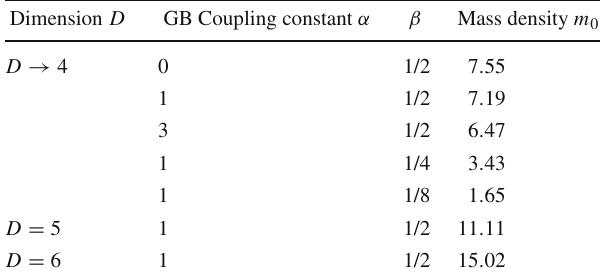
Table 1 The mass density (62) of the cosmic string for different values of the GB coupling constant α and string thickness. We choose α = 0, α = 1, and α = 3 in order to reveal the contributions of the GB term on the spacetime geometry. The mass densities with different values of the parameter β reflect the contribution of the string mass to the spacetime geometry. The parameter D is respectively set to D → 4, D = 5, and D = 6 to show the variation of the string mass density in different dimensions. In each set, the parameter k is fixed to unit Dimension